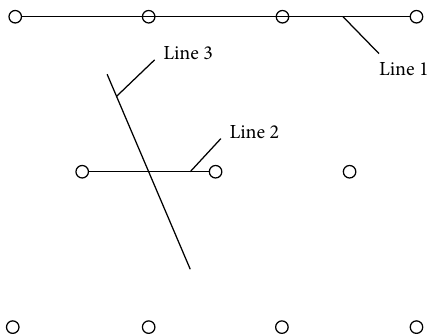
Figure 6: The structure line of the value line graph.